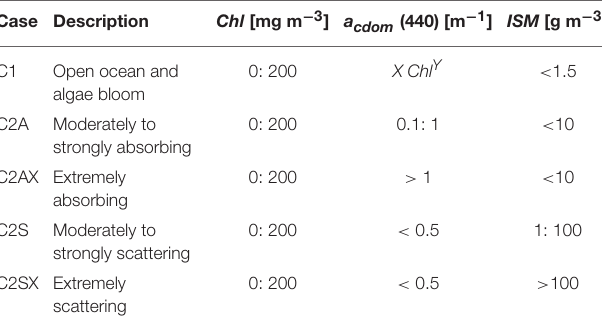
TABLE 1 | Water case sub-classification that characterize the database in view of concentration ranges of chlorophyll, CDOM, and inorganic suspended